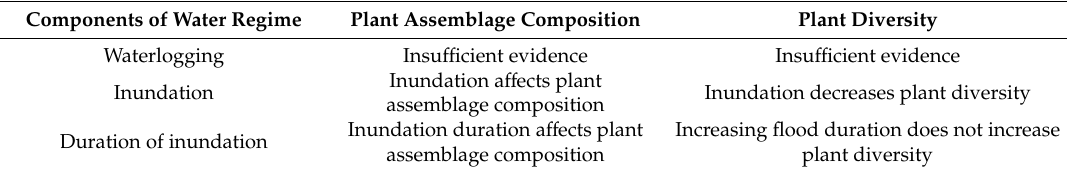
Causal criteria analysis results for hypotheses linking changes in wetland plant assemblage-composition and plant diversity, to increases in components of the water regime according to a systematic review carried out in